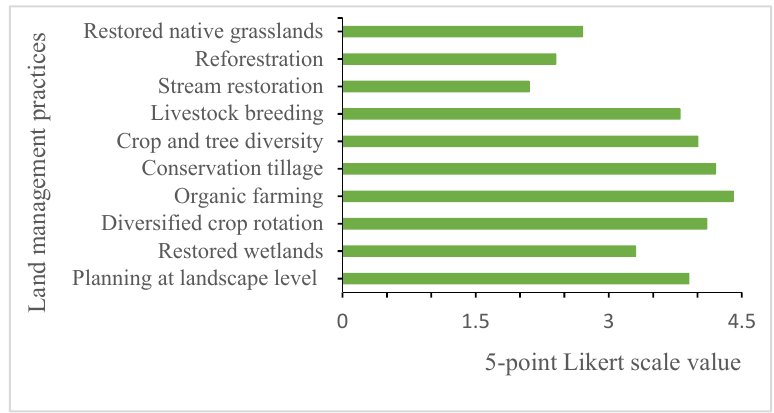
Figure 4. Ten most important land management practices.